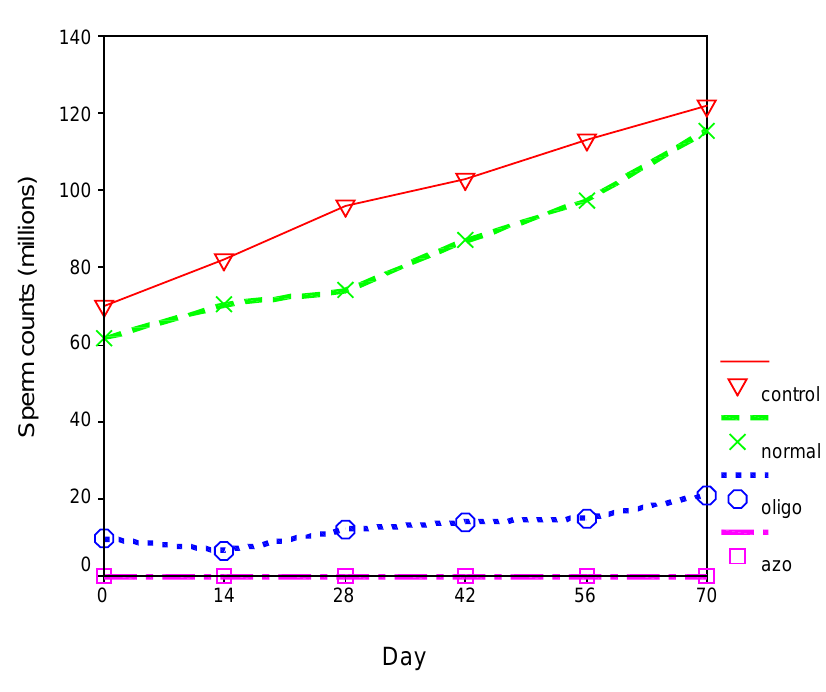
FIGURE 2. Effect of C. populnea aqueous extract on sperm